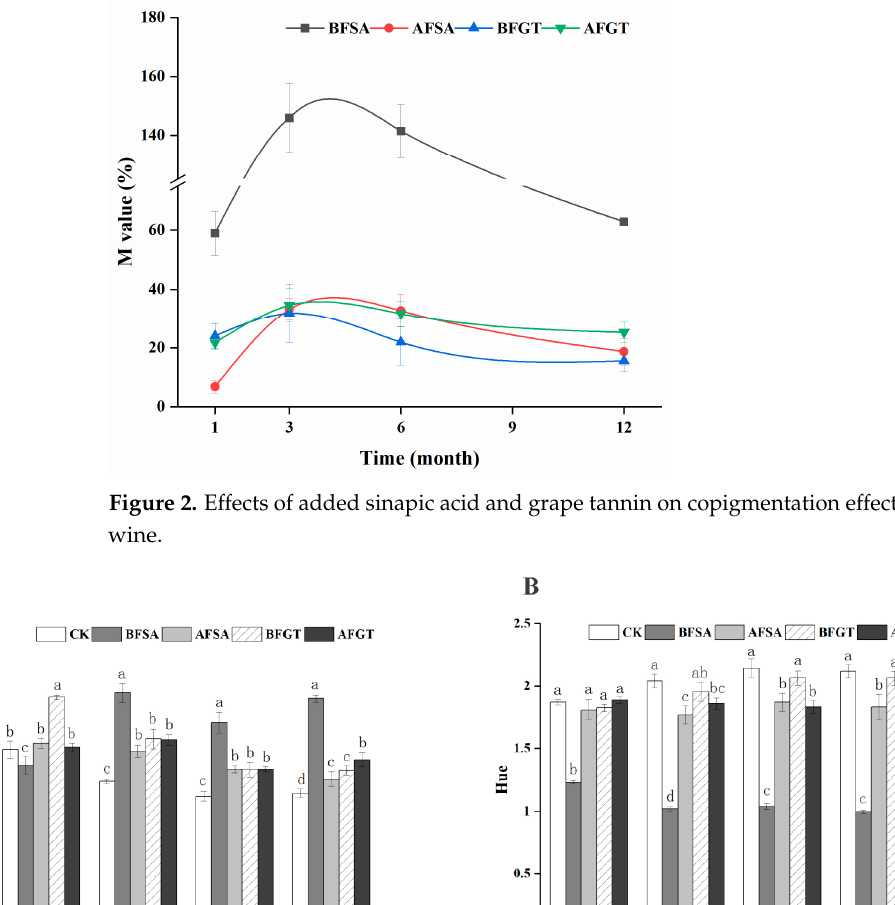
Figure 2. Effects of added sinapic acid and grape tannin on copigmentation effect value (M) of cherry wine.